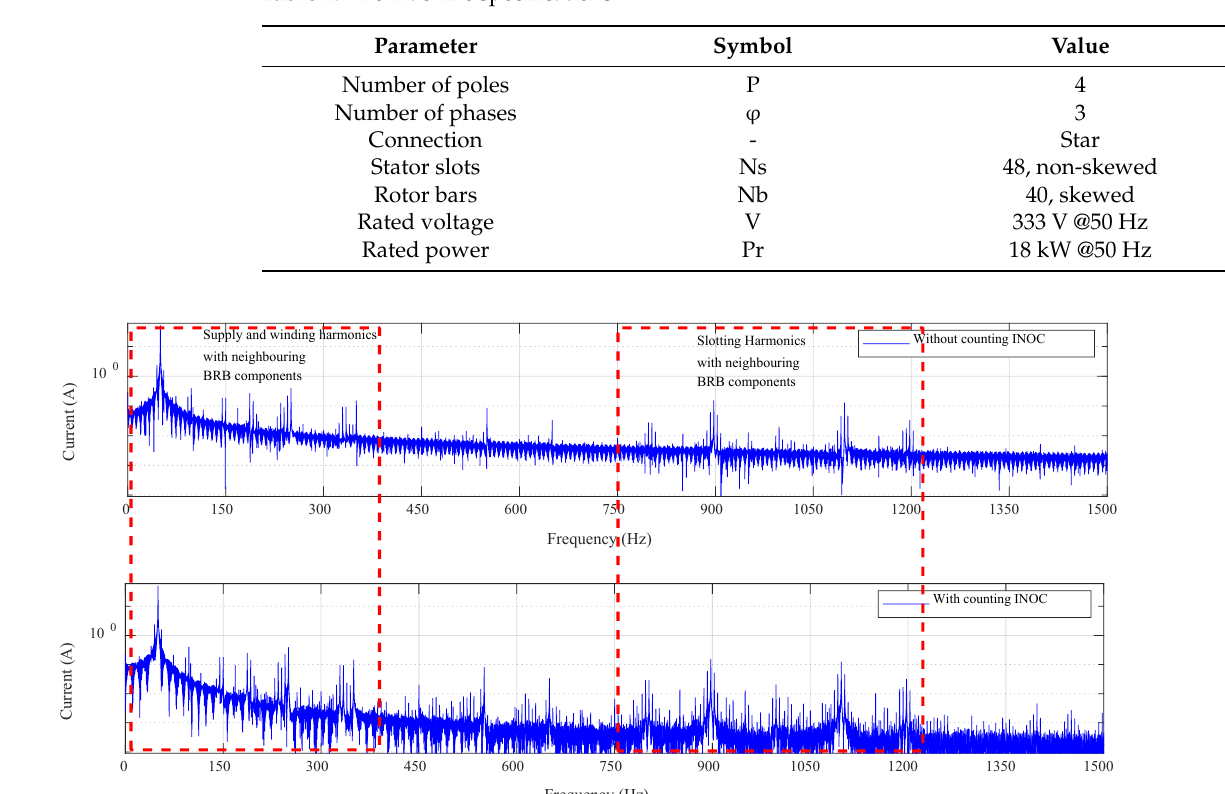
Table 2. The machine specifications.